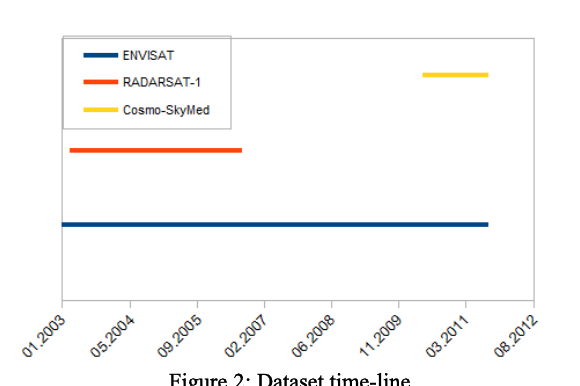
Figure 2: Dataset time-line